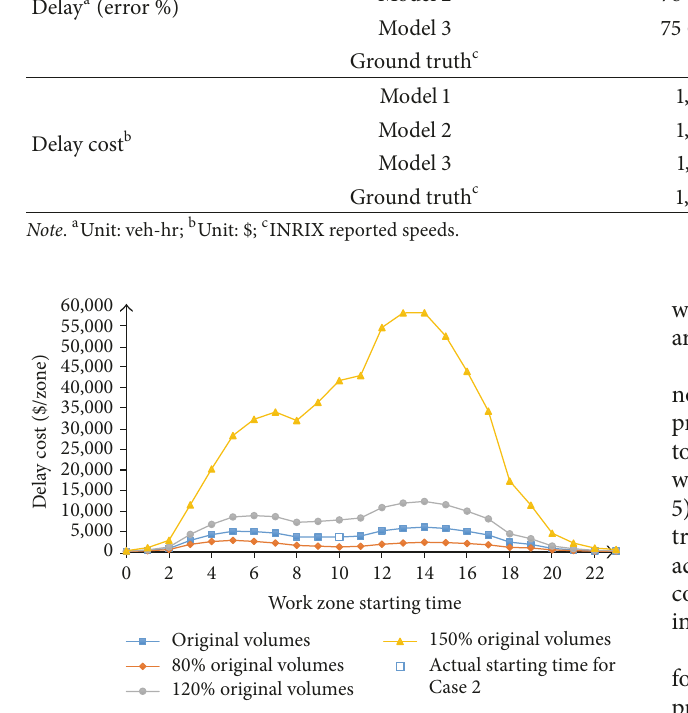
Figure 5: Predicted delay costs versus starting time for various traffic volumes (Case